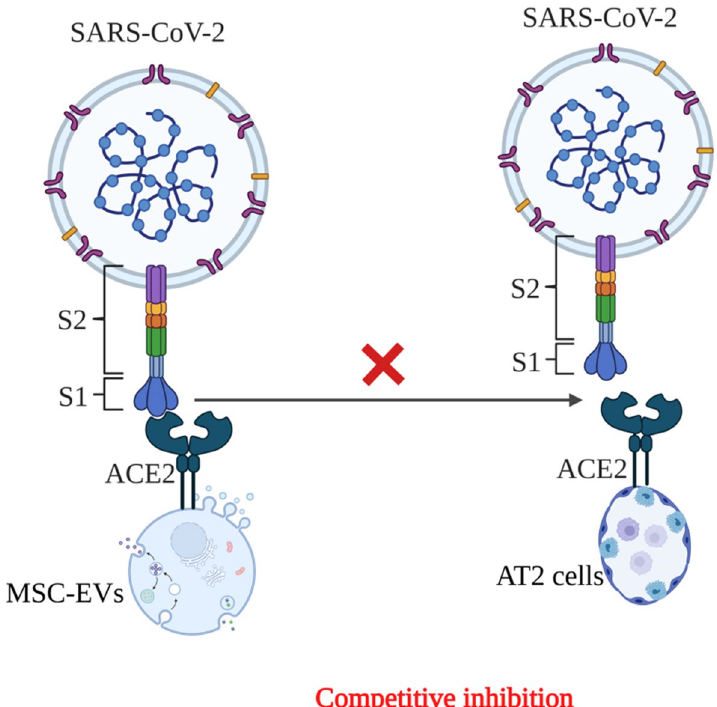
Fig. 4 MSC-EVs expressing ACE2 receptor competitively binds to SARS-CoV-2 and prevents the binding of SARS-CoV-2 to AT2